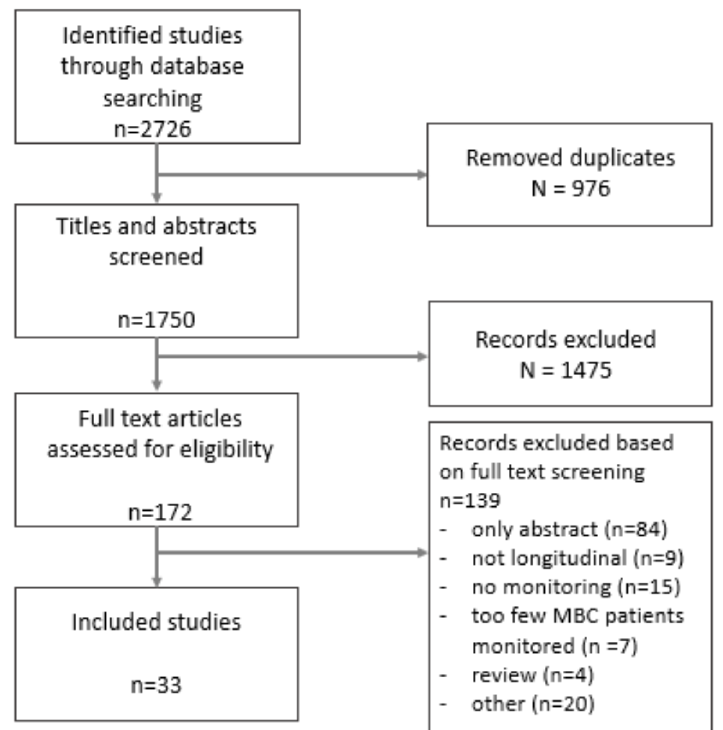
Figure 1. Flowchart of selection of studies.